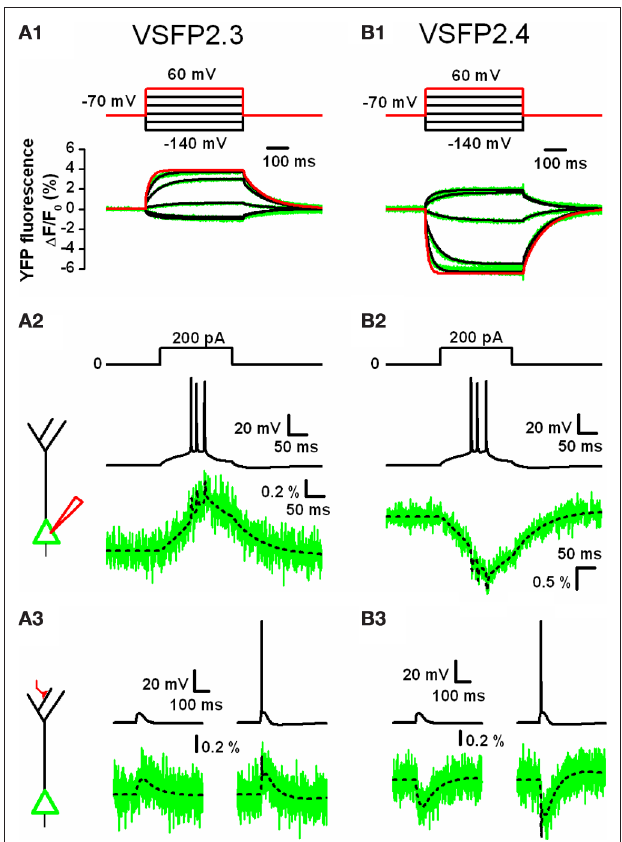
FIGURE 4 | Computer simulations of VSFP2.3 and VSFP2.4 optical response signals in cortical layer 5 (L5) pyramidal neurons. (A1) Family of YFP fl uorescence ( Δ F / F ) responses (lower panel; green traces) to 0 500 ms voltage steps (upper panel) from a holding membrane voltage of − 70 mV to test potentials of − 140 to + 60 mV recorded from voltage- clamped PC12 cells expressing VSFP2.3. Overlaid to the experimental traces are simulated traces obtained from a VSFP2.3 model wherein the kinetics are represented as an eight state Markov process as given in (Akemann et al., 2009). The simulated response to + 60 mV is highlighted in red. (A2) Predicted VSFP2.3 fl uorescence signal ( Δ F / F ; lower panel) in 0 response to an action potential burst (middle panel) in the cell body of a simulated L5 pyramidal neuron evoked by constant current injection (upper panel). The schematic to the left depicts the neuron with a point current source attached to the cell body (red electrode). The electrical response was simulated using a conductance-based model of a reconstructed rat L5 neuron given by Mainen and Sejnowski (1996). VSFP2.3 was homogenously inserted within the membrane (all 177 compartments) at a density of 800 units/µm 2 . The fl uorescence signal (lower panel) represents the response of VSFP2.3 in the somatic membrane with (green) or without (dashed black) photon quantum noise calculated assuming a sampling rate of 2 kHz and excitation light level that bleaches GFP within 10 s of ; lower panel) as illumination. (A3) VSFP2.3 fl uorescence signal ( Δ F / F 0 predicted by the simulation in response to a subthreshold (left column) or suprathreshold (right column) activation of a distal synaptic conductance (schematically depicted to the left with the activated synapse in red). The voltage signal in the cell body (upper row left: EPSP; upper row right: EPSP plus evoked action potential) together with the associated fl uorescence signals (lower row), with (green) or without (dashed black) photon quantum noise are shown. (B1–B3) Same as in (A1–A3) , but using a model of VSFP2.4 instead of VSFP2.3. VSFP2.4 was simulated as an eight state Markov chain model analogously to VSFP2.3. For methodological details see Akemann et al.